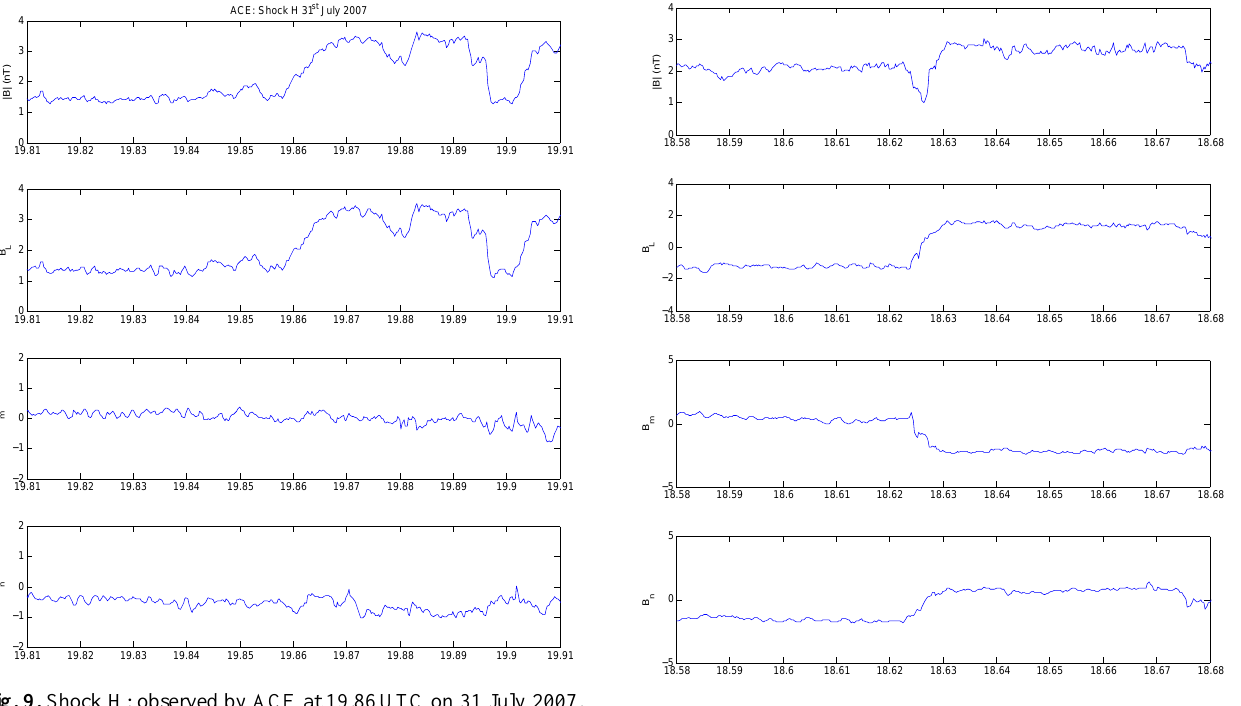
CME associated shock crossings that may have occurred